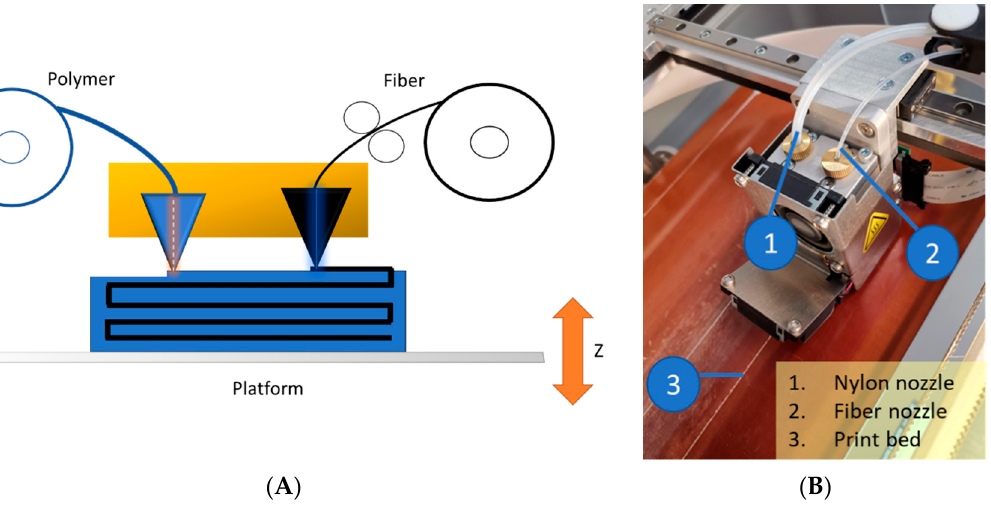
Figure 1. ( A ) Schematic representation of the 3D printing process for continuous fiber-reinforced polymer composites and ( B ) a photograph of the 3D printer used in the study.